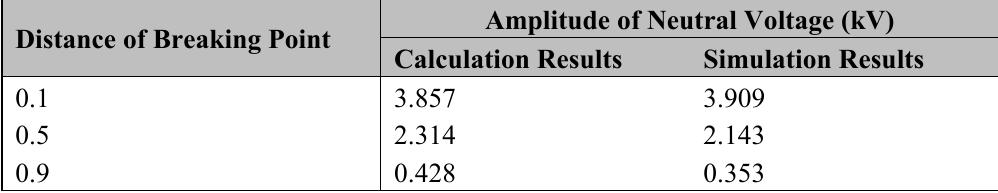
Table 1. Comparisons of calculation results and simulation results.